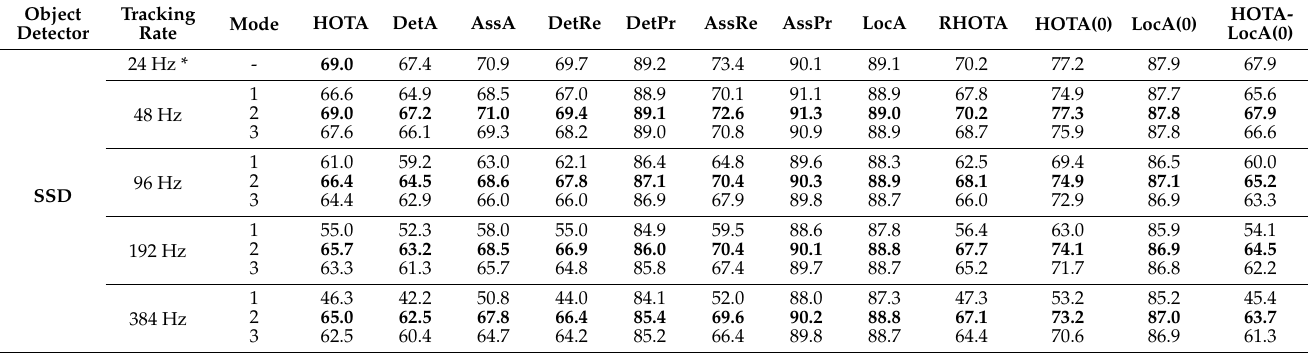
Table 1. Hybrid object detection and tracking results using HOTA metrics at different temporal resolutions, using the frame-based object detector SSD. The results are shown for the three different event-based, inter-frame, tracking modes described in Section 3. Our approaches represented by Modes 2 and 3 show significant promise regarding the ability to leverage event data to generate accurate high-temporal-resolution tracking results. The best metric value at each rate is in bold.